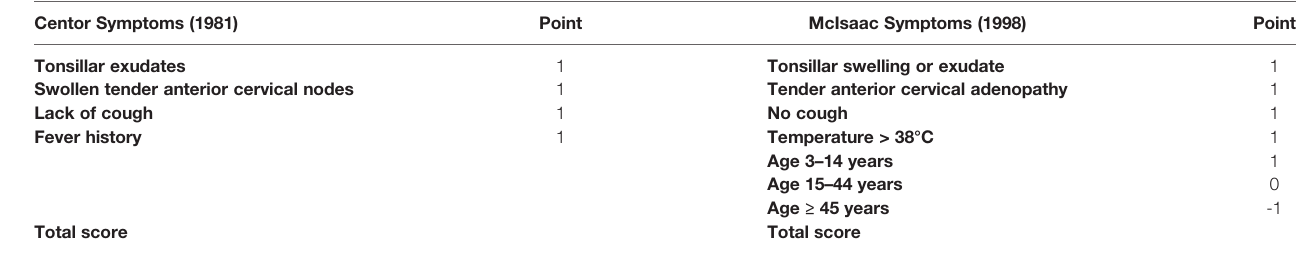
TABLE 1 | Comparison of Centor vs. McIsaac Scoring Systems. Centor Symptoms (1981)